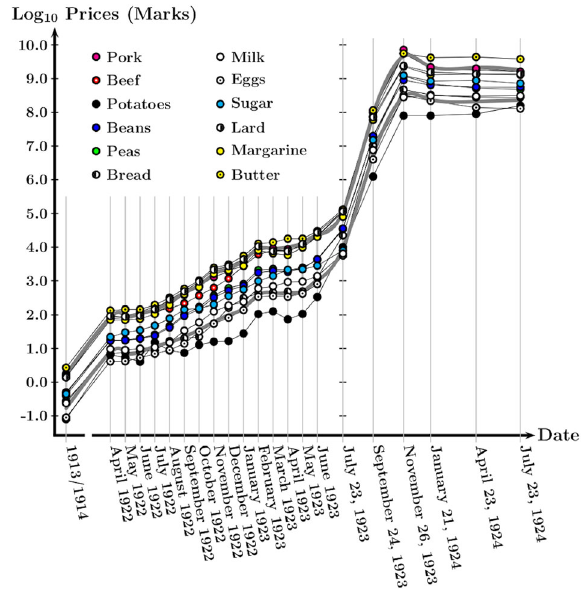
Fig. 1 The German hyperin fl ation. Circles indicate the base 10 logarithms of prices. Straight grey lines joining these show the evolution in price of individual items (such as “ bread ” or “ milk ” ). Most prices tend to fall within a band, given by the mean plus or minus one standard deviation. The upper and lower limits of the band are plotted as dark grey curves which have been smoothly interpolated between dates with data. Vertical dark grey bars indicate its width at dates for which data is